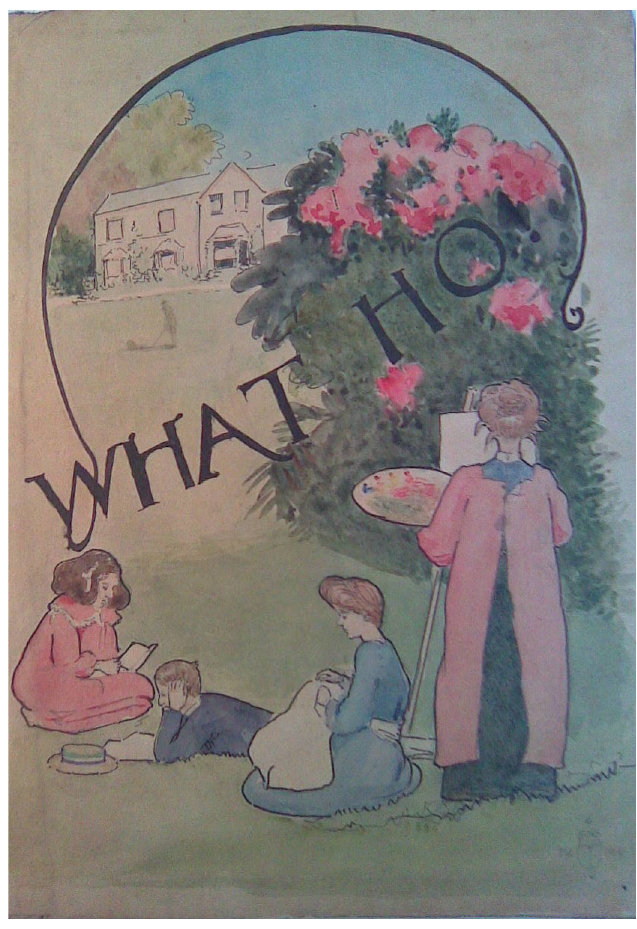
Figure 5. Cover of What Ho! (1905) (Courtesy of Abbot Hall,